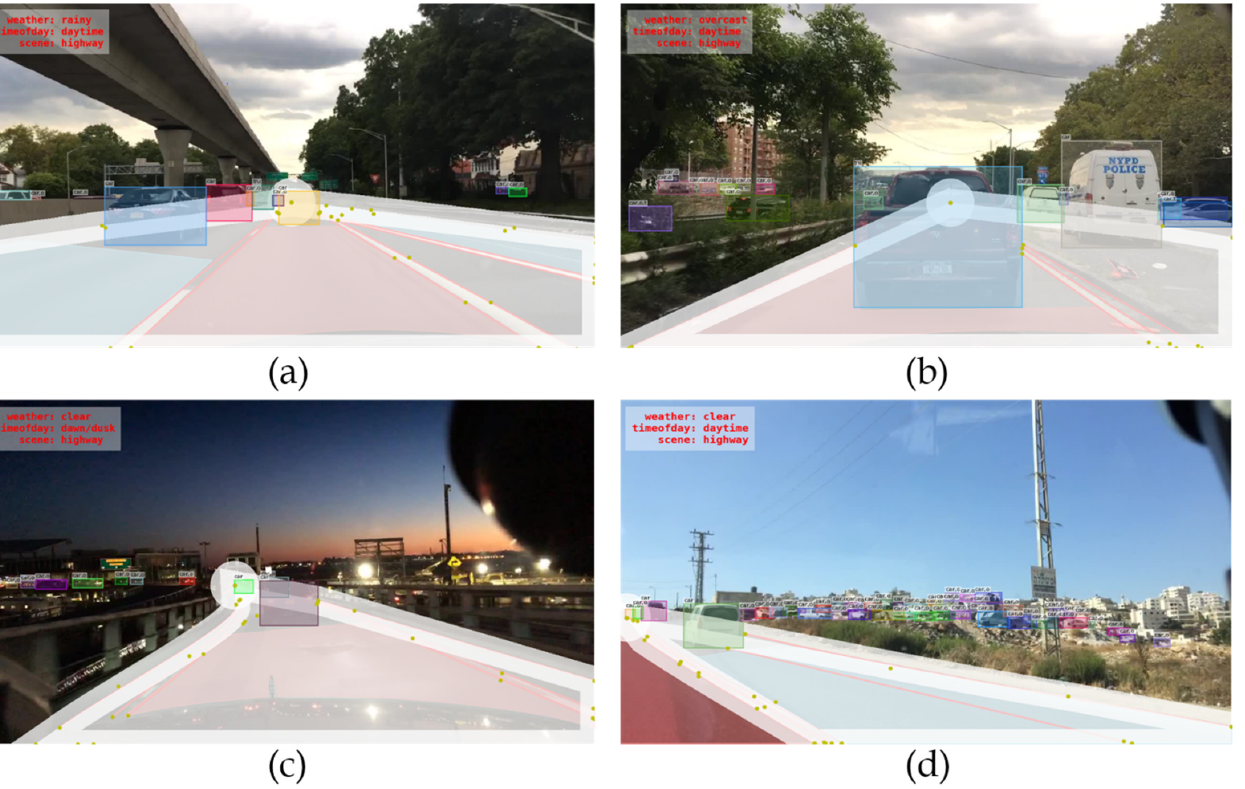
Figure 12. ( a – d ) Examples of negligible objects outside the